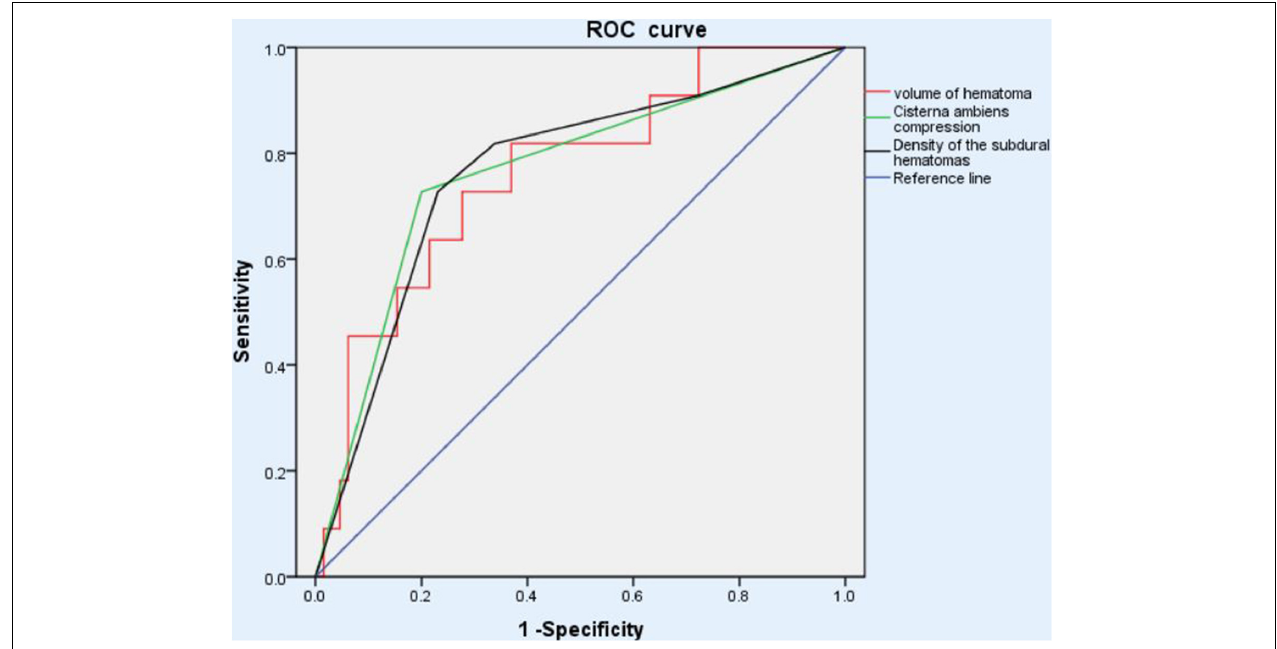
FIGURE 2 | ROC analysis of different outcome to atorvastatin monotherapy showed that the basal cistern compression, volume of hematoma and hyper-density had the AUCs, 0.764 ( p = 0.005), 0.762 ( p = 0.006), and 0.748 ( p = 0.009), respectively, suggesting medium predictability for therapeutic effect. ROC, receiver operating